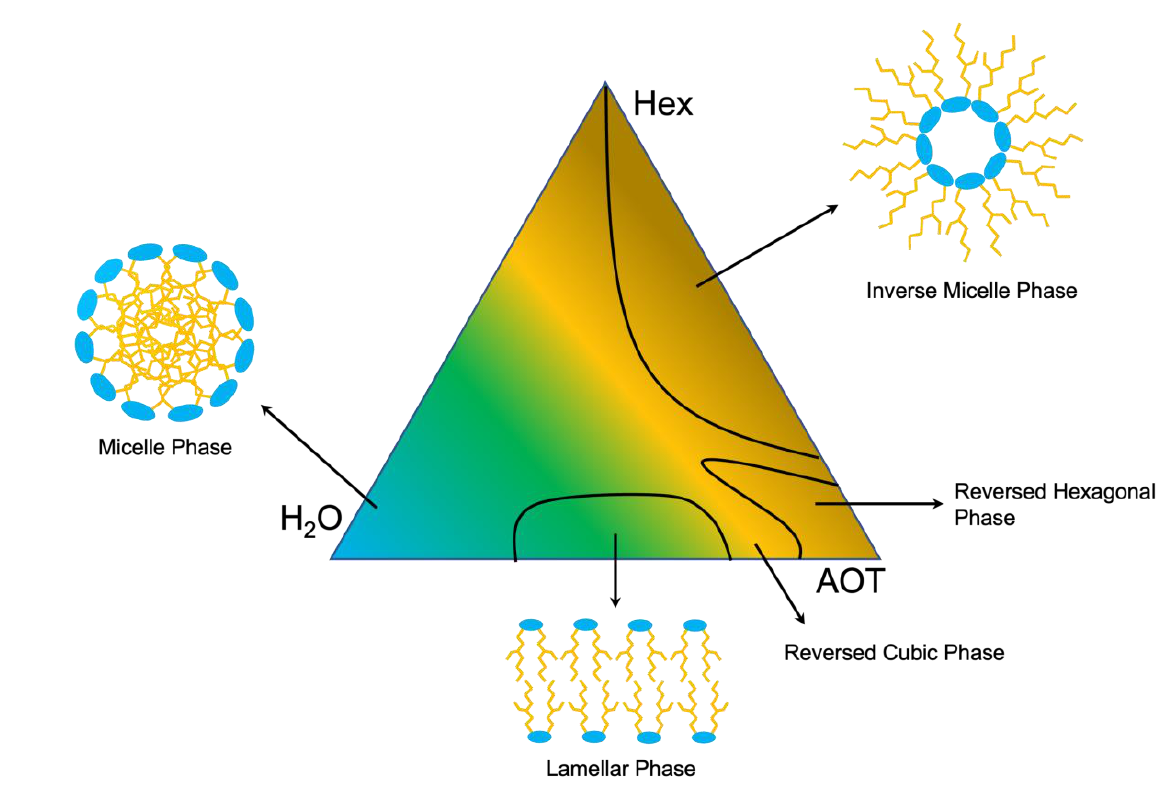
Figure 7. Phase diagram of water:hexanes:AOT used in the water-in-oil emulsification method. Table 2. Experimental parameters and results of the alginate nanoparticle synthesis by water-in-oil emulsification. Final alginate and CaCl 2 concentrations in the sample are provided. Emulsions were formed with a water:hexanes:AOT weight ratio of 40:40:20.